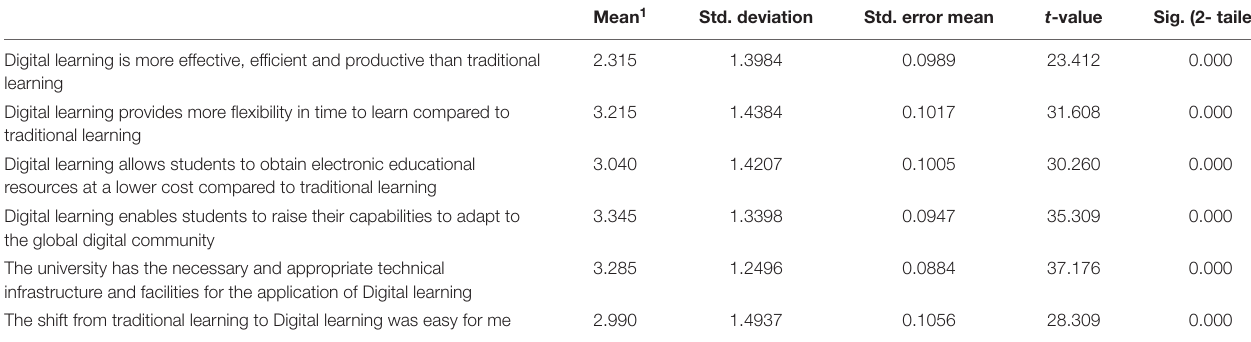
TABLE 3 | One sample T -test (Section 1: Digital learning: effectiveness versus traditional learning, costs, capabilities, and educational resources). Mean 1 Std. deviation Std. error mean t -value Sig. (2- tailed)